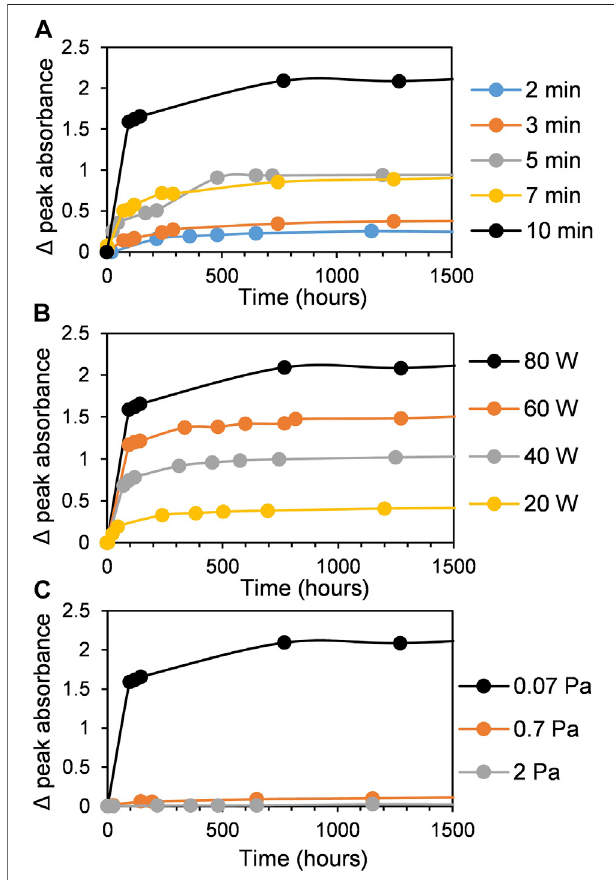
FIGURE 6 | The evolution of the absorbance at the maximum of SPR band (505 nm) as a function of time. (A) Effect of sputter time, (B) effect of sputter power, and (C) effect of argon pressure.